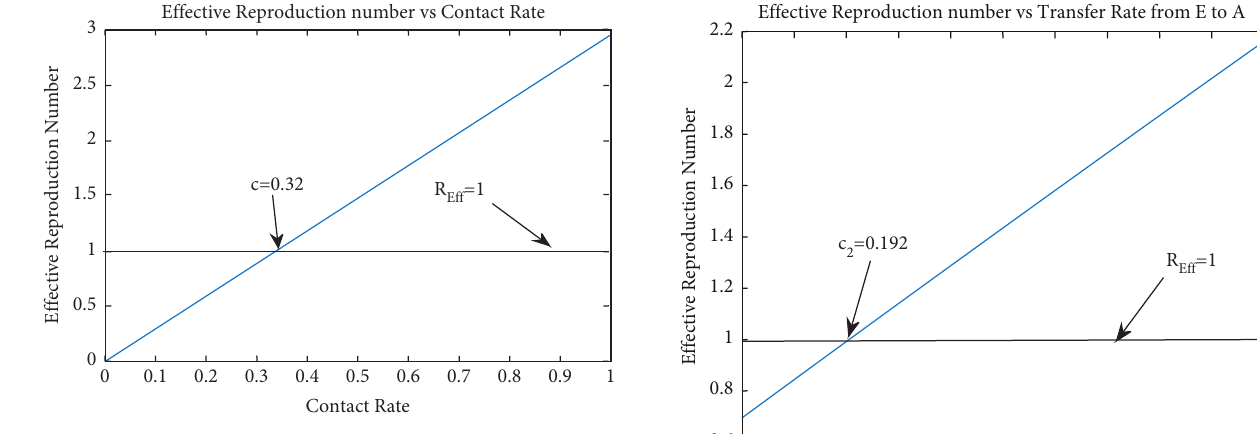
Figure 4: Behavior of effective reproduction number in relation to contact rate, c .